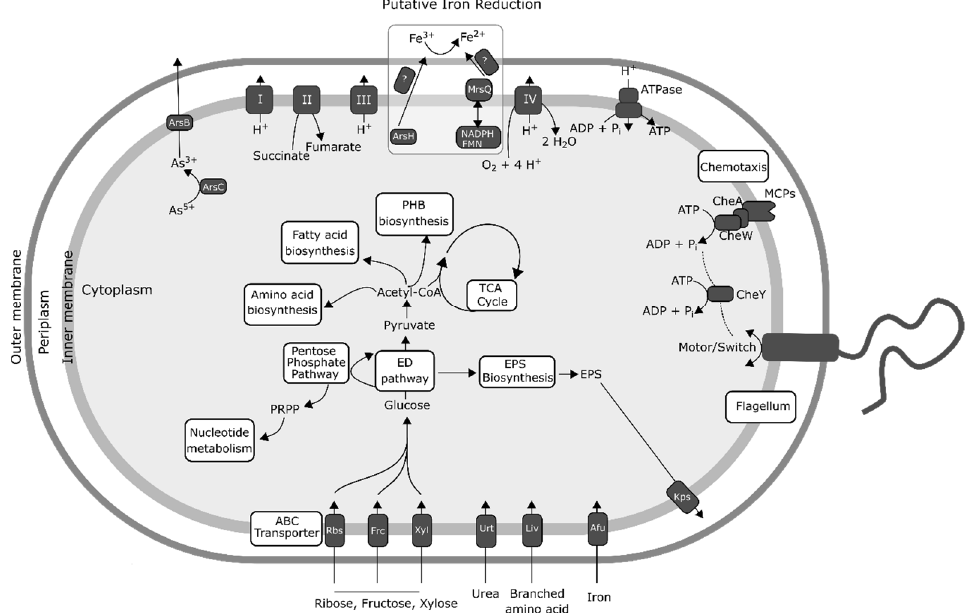
Figure 4. Genomic potential of Acidiphilium sp. C61, based on gene annotations described in the newly